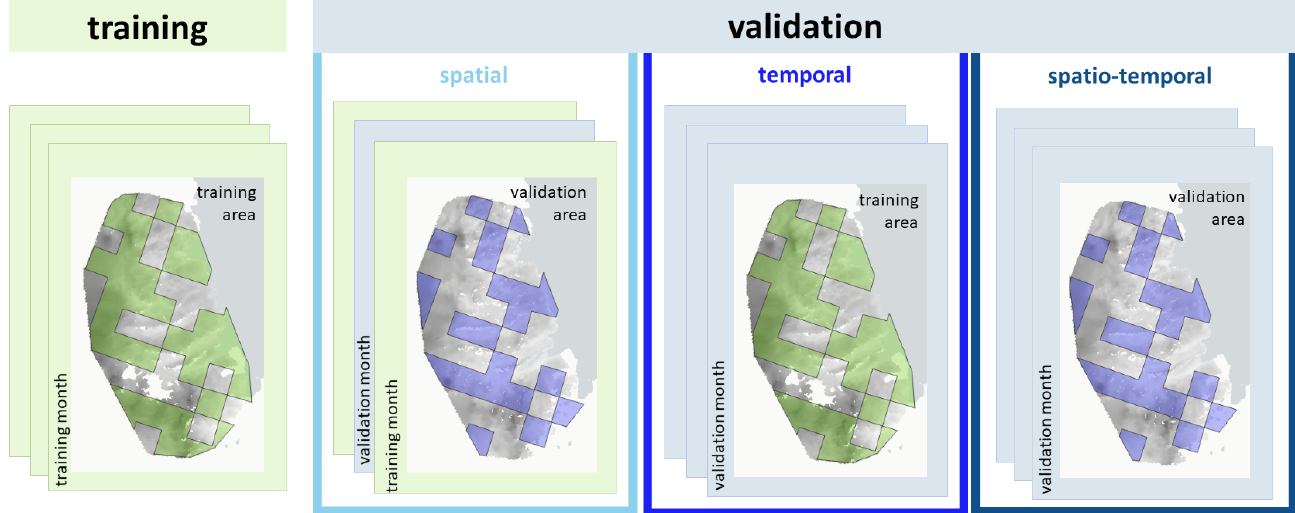
Figure 3. Schematic representation of training and validation data sets. Green boxes indicate months that went into training, blue boxes indicate months that were used for temporal external validation. The green and blue areas within the map represent the training and validation areas,